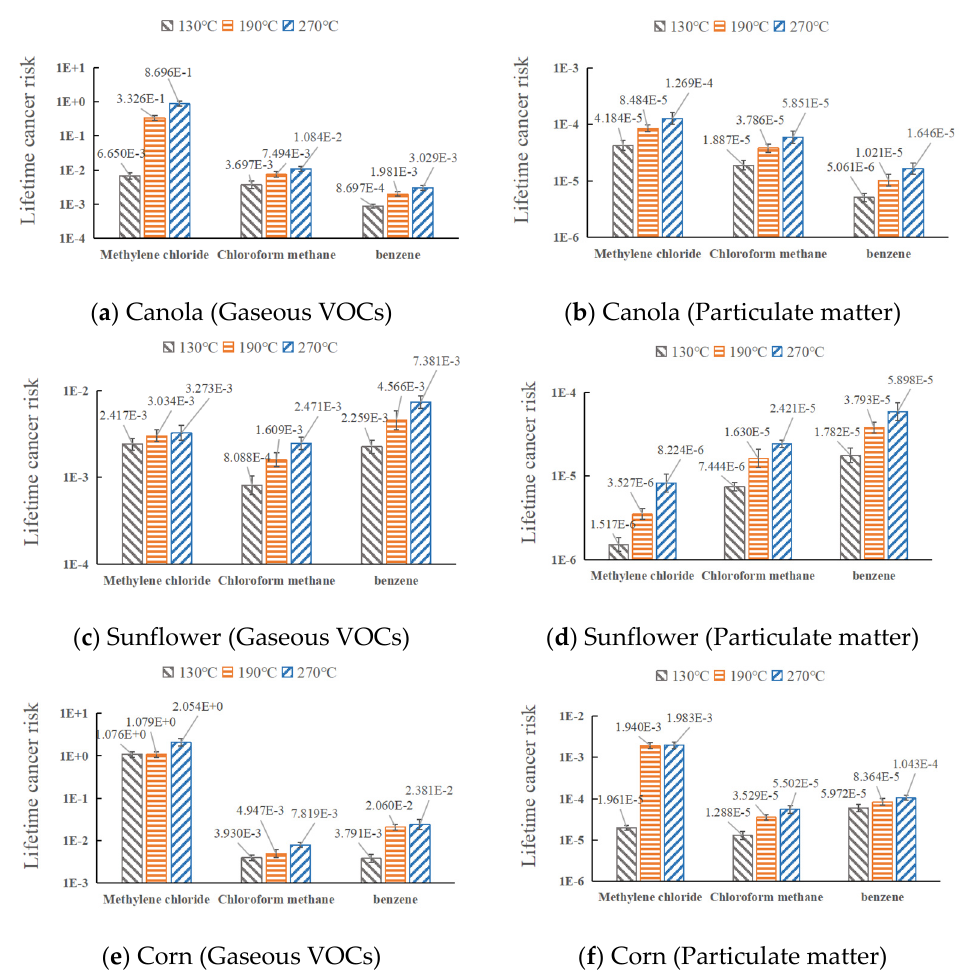
Figure 7. Cancer risk of selected pollutants in cooking fume. The LCR values of the three oils in gaseous VOCs all exceeded 10 − 4 , indicating a high potential carcinogenic risk. The canola and corn oils both had LCRs that exceeded the limit value in particulate matter, whereas the sunflower oil had LCRs that were within the potential risk range (10 − 6 –10 − 4